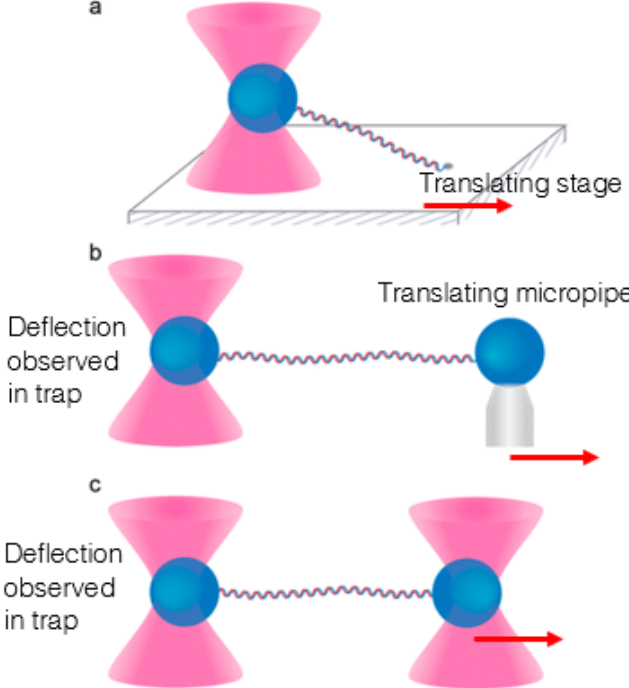
Figure 2. Three different methods for stretching a DNA tether with optical tweezers can be seen in this figure: the translating slide method ( a ), using an anchoring micropipette ( b ) and using two separate optical traps ( c ). Reproduced with permission from Reference [75]. c (cid:13) 2014 American Chemical